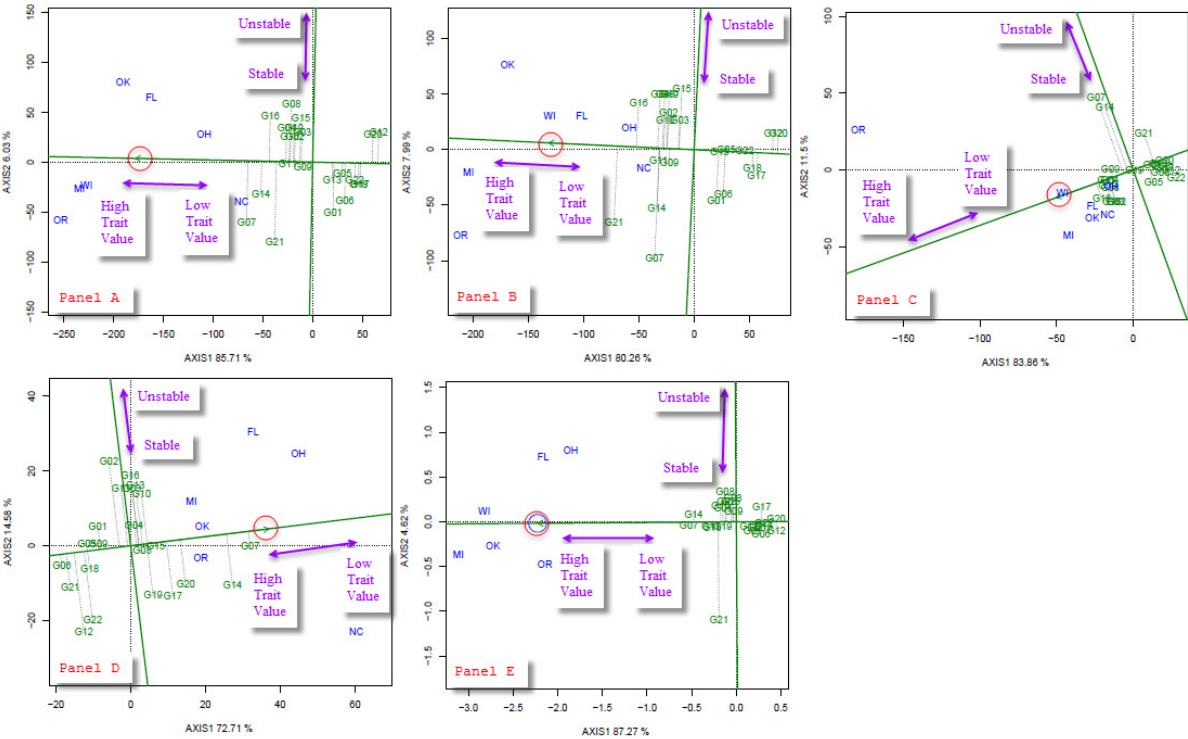
Figure 3: The mean vs. stability view of genotype main effects plus genotype x environment interaction effect (GGE) biplot of 22 cucumber genotypes tested in 3 years and 7 locations for total yield (Panel A), marketable yield (Panel B), early yield (Panel C), percent cull (Panel D) and fruit plant -1 (Panel E). The biplots were based on ‘Scaling = 0’, ‘Centering = 2’ and ‘SVP = 1’. The ‘ideal’ genotype is represented by a circle on average environment coordinate (AEC)-abscissa which passed through biplot origin. Key to the labels of genotype and management practices is presented in abbreviation